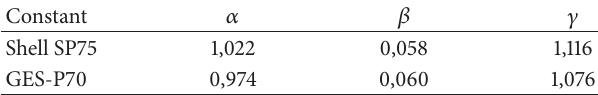
Table 2: Constants estimation for PV